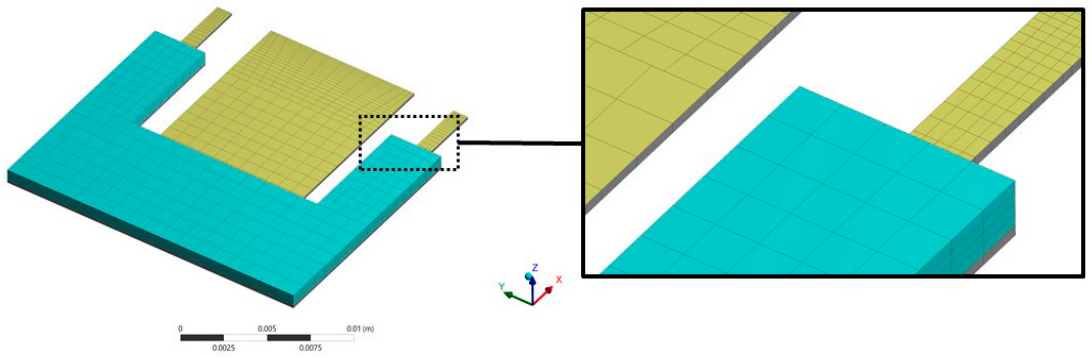
Figure 7. View of the mesh employed in the FEM model of the pVEH microdevice.